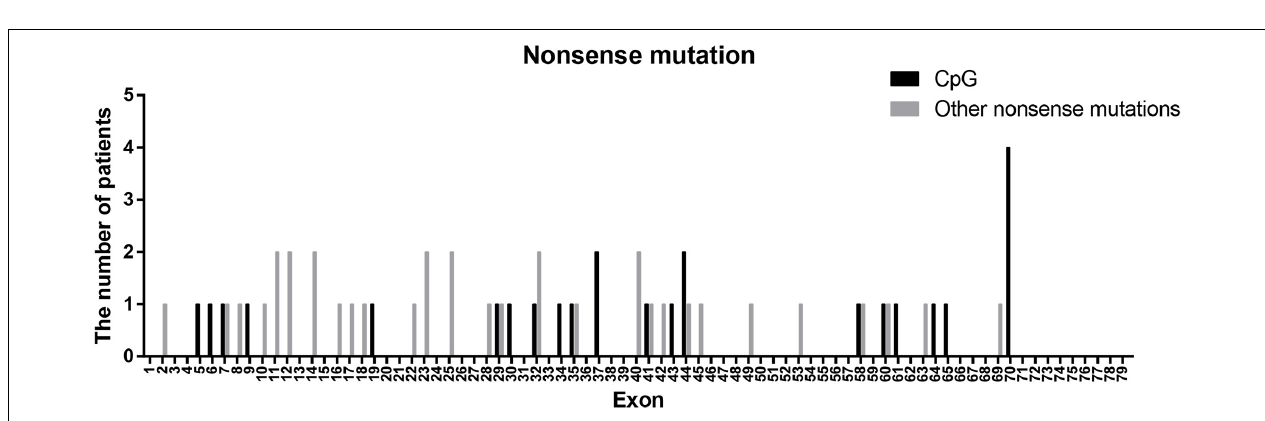
FIGURE 3 | Positional distributions of small mutations. (A) Distribution of exons in which mutations are located. (B) The ratios of mutation types in DMD domains. (C) Distribution of domains in which mutations are located. Distributions of splicing mutation were classified to consensus exons.